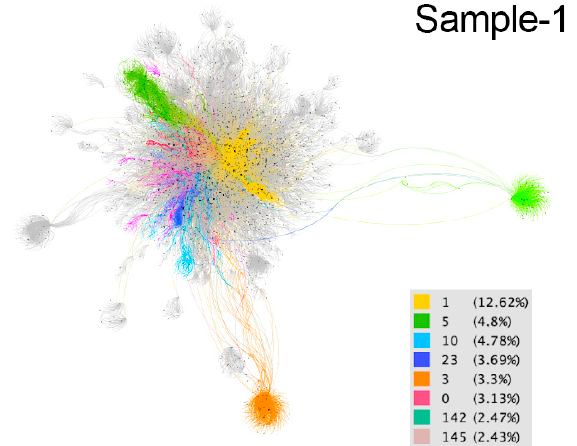
Figure 2. Graph of sample 1. Community detection based on modularity [66] and according to intermediation centrality [63] of sample 1. Source: Gephi [67].